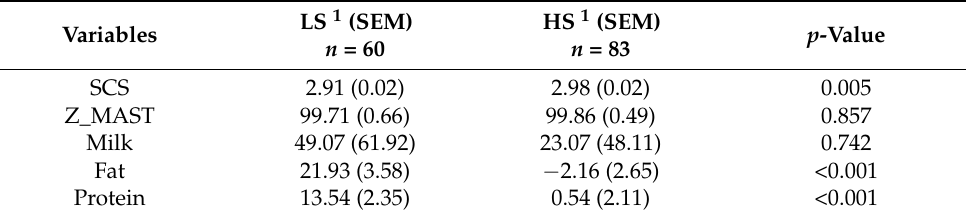
Table 1. Mean values of genomic indexes from Zoetis Clarifide Plus genomic testing system. Differ- ences were statistically tested through t -test (SEM and p -value are reported, where available). LS 1 (SEM) HS 1 (SEM) p -Value Variables n = 60 n = 83 SCS 2.91 (0.02) Z_MAST 99.71 (0.66) 99.86 (0.49) Milk 49.07 (61.92) Fat 21.93 (3.58) − 2.16 (2.65) <0.001 Protein 13.54 (2.35) 0.54 (2.11)